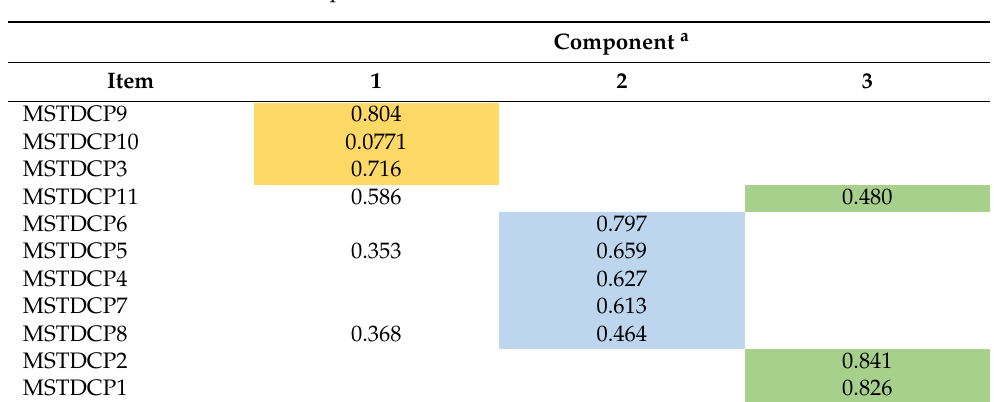
Table 7. Stress Scale rotated component matrix.